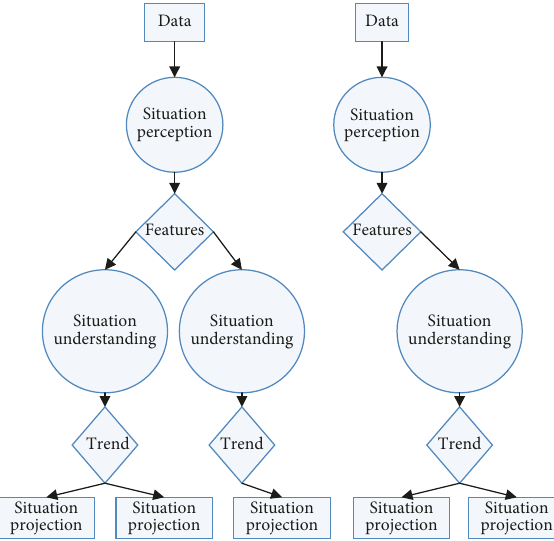
Figure 2: security situation awareness model based on a random